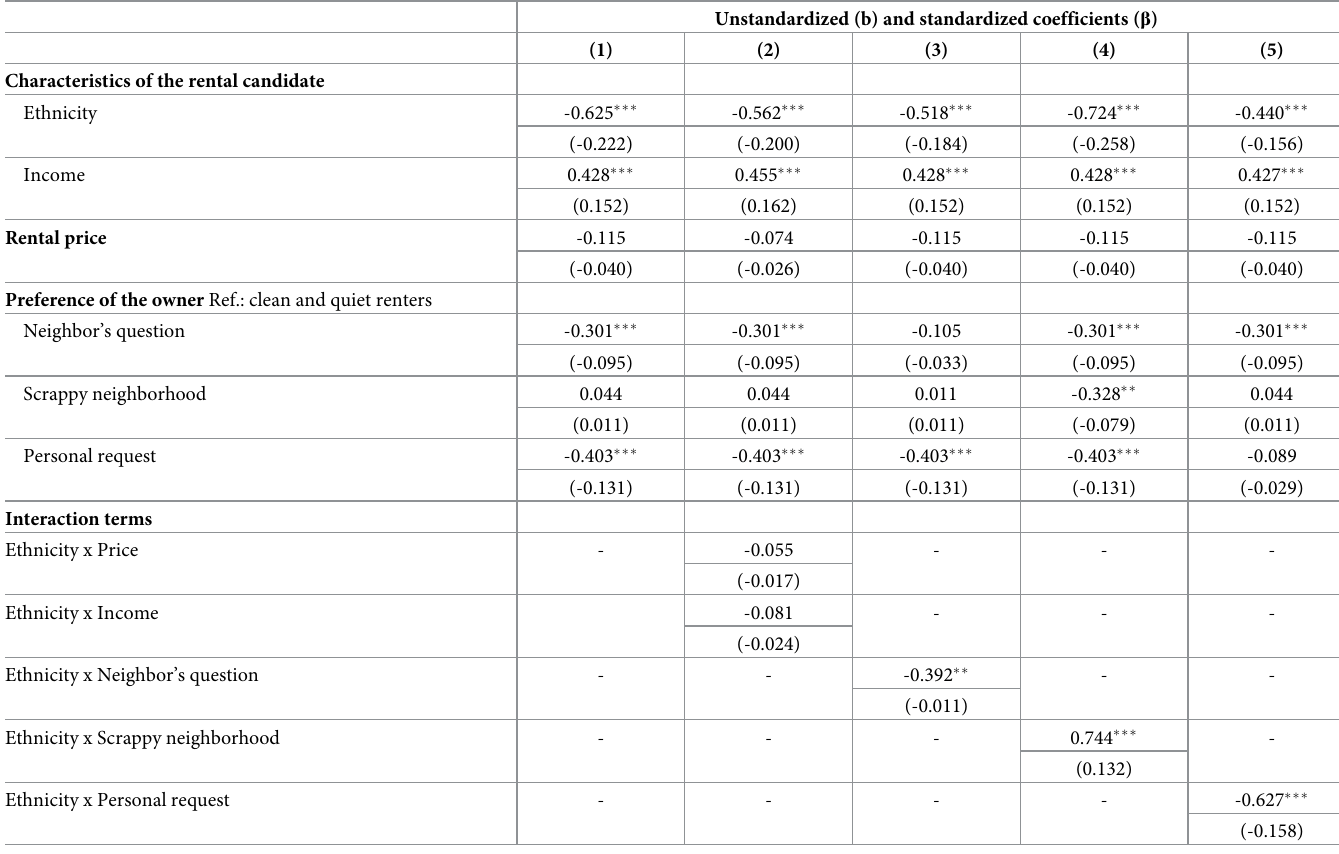
Table 7. Linear regression analyses of the invitation